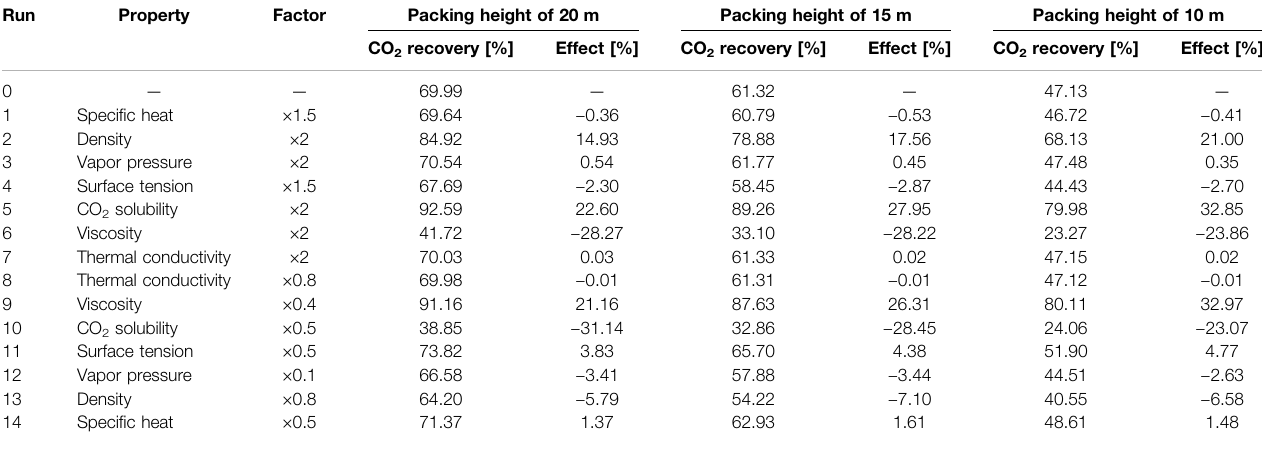
TABLE 6 | Sensitivity analysis of solvent properties with Hanley and Chen (2012) correlations (lean solvent fl ow rate of 6,581 kg/s). Run